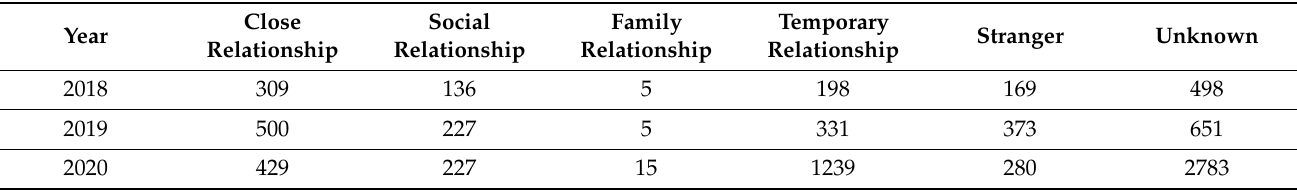
Table 3. Relationship of the Perpetrator to the Victim by Year